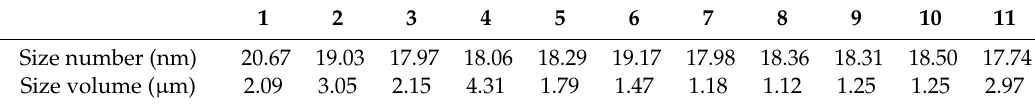
Table 2. Particle size averages determined by dynamic light scattering (DLS) in number and volume.